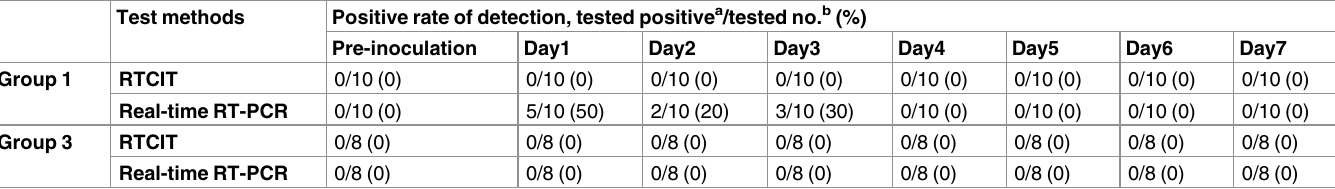
Table 1. SAG2 virus excretion in the saliva of Formosan ferret badgers in the safety study. Test methods